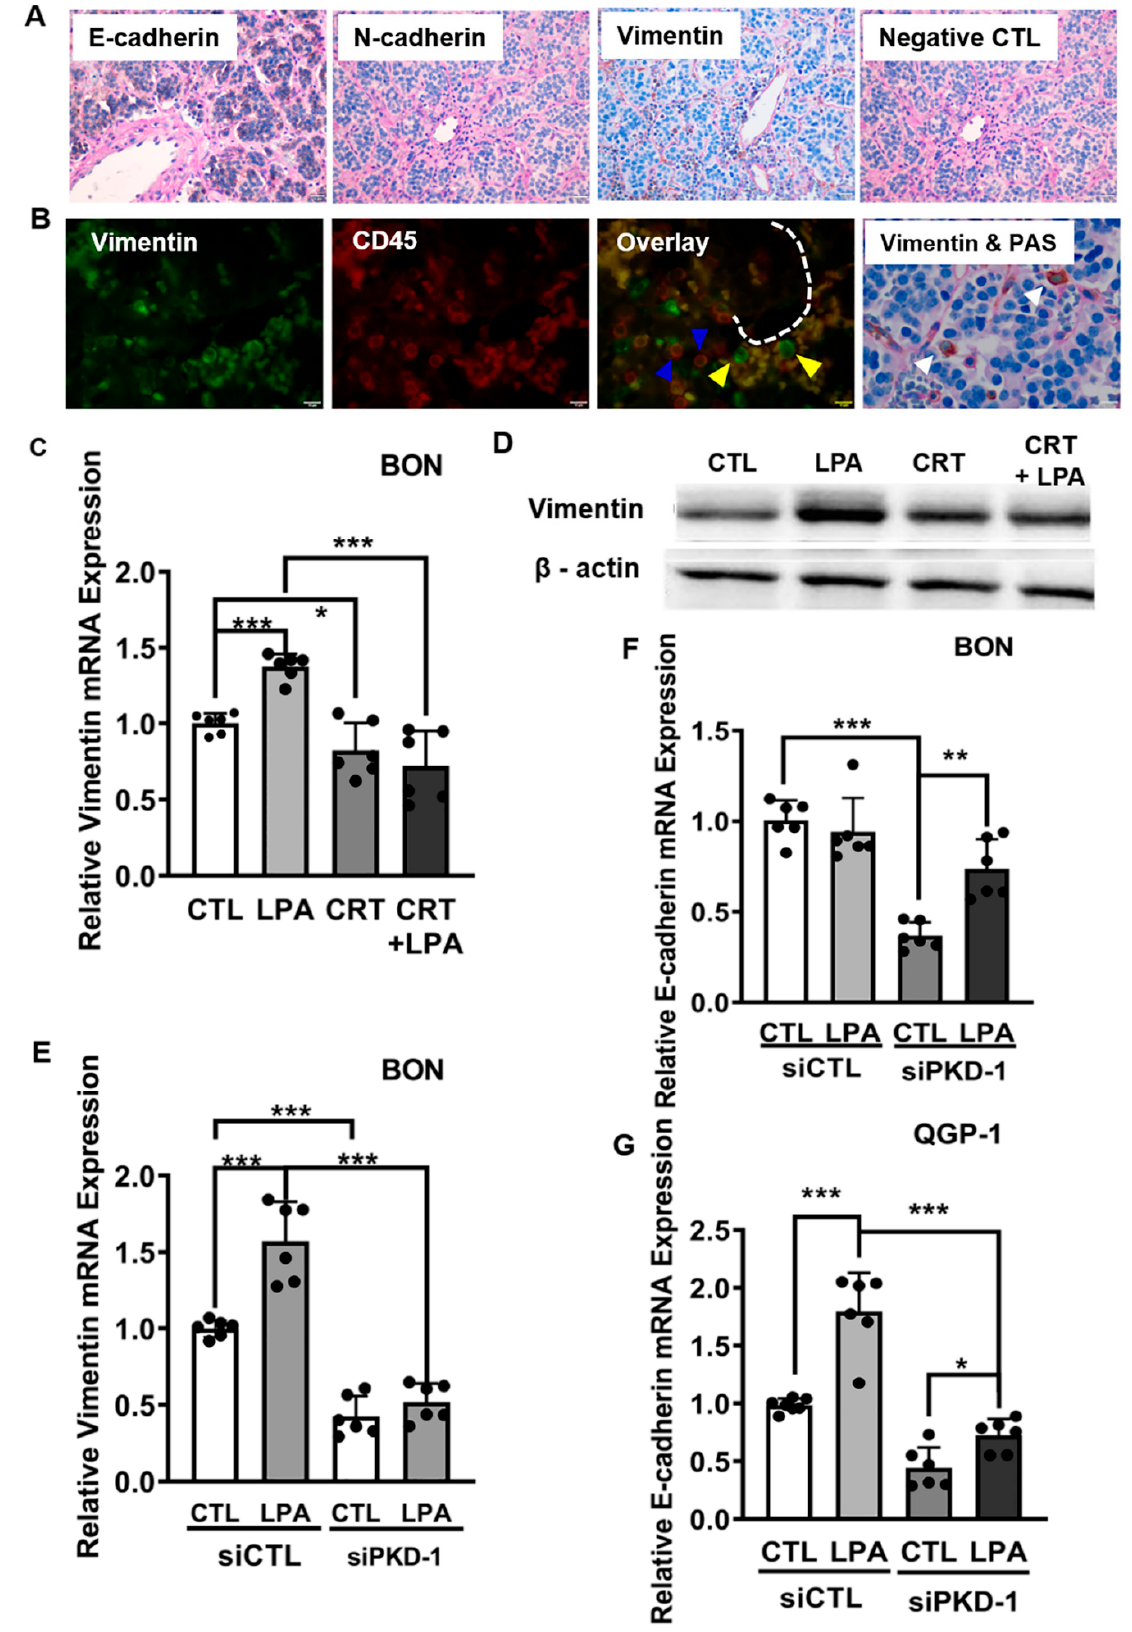
Figure 4. Regulation of EMT by PKD1 signaling in pNETs. ( A ) Human pNET tissues were stained with E-cadherin, N-cadherin and vimentin antibodies by immunohistochemistry (IHC), along with